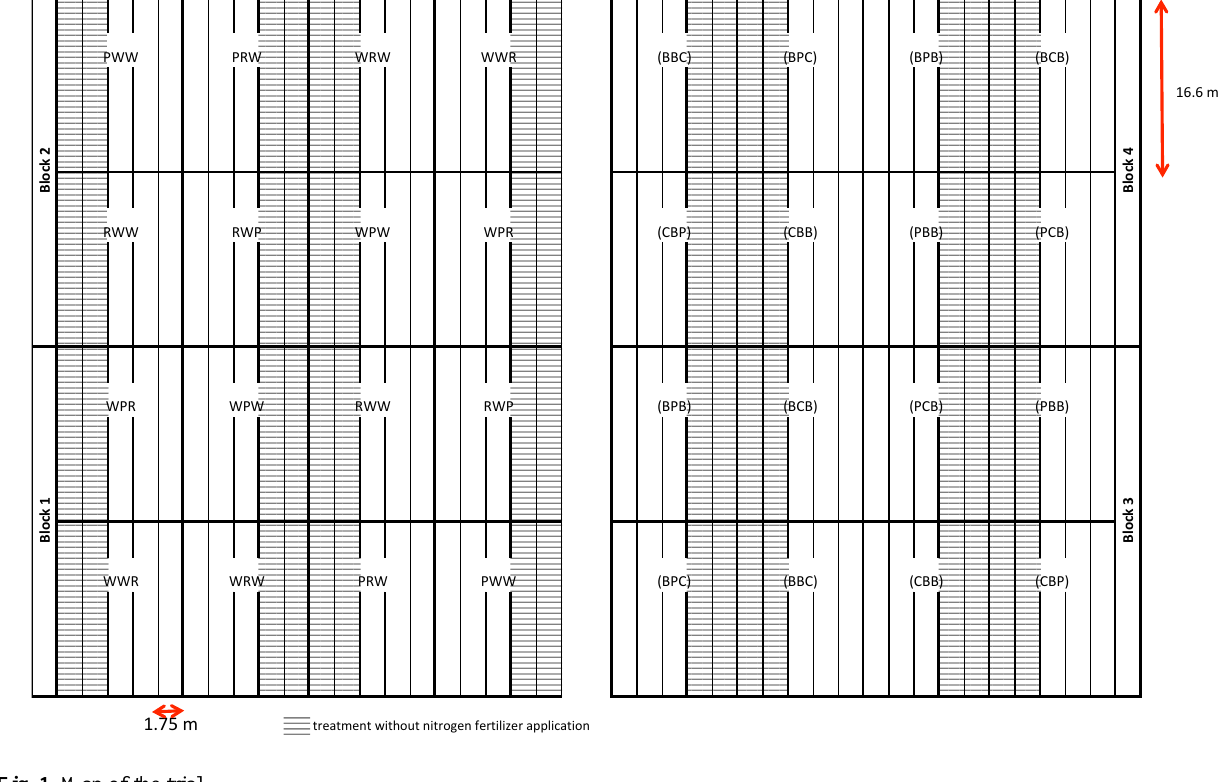
Figure 1: Map of the trial Fig. 1. Map of the trial. Table 1. Crop sequences in the field trial over the five years (first column, W=winter wheat; R=rape;